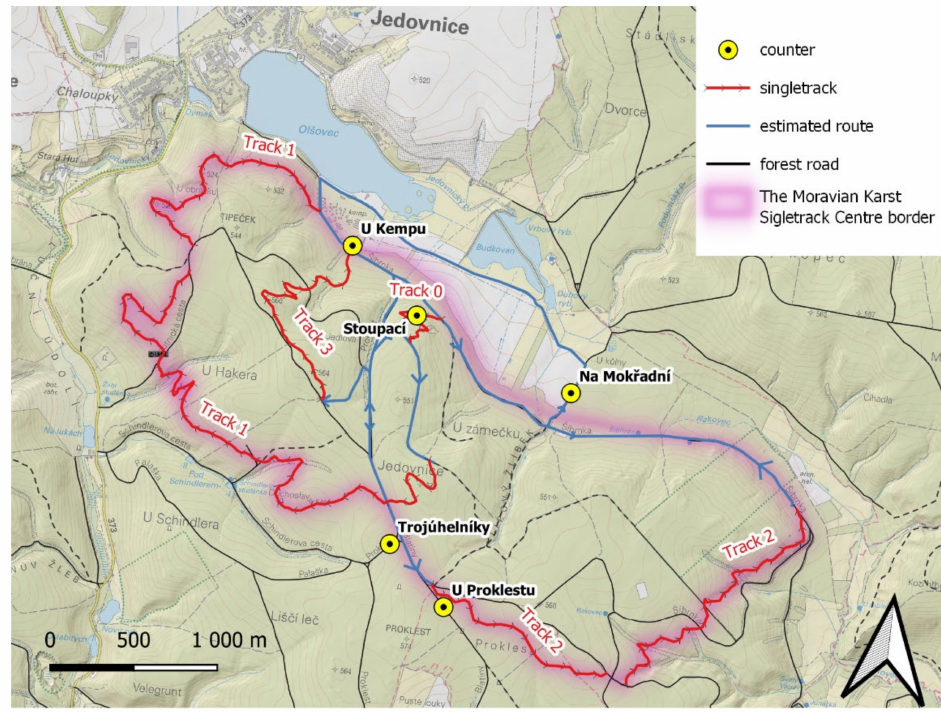
Figure 2. Locations of counters for data measuring in the Moravian Karst Single Track Centre.